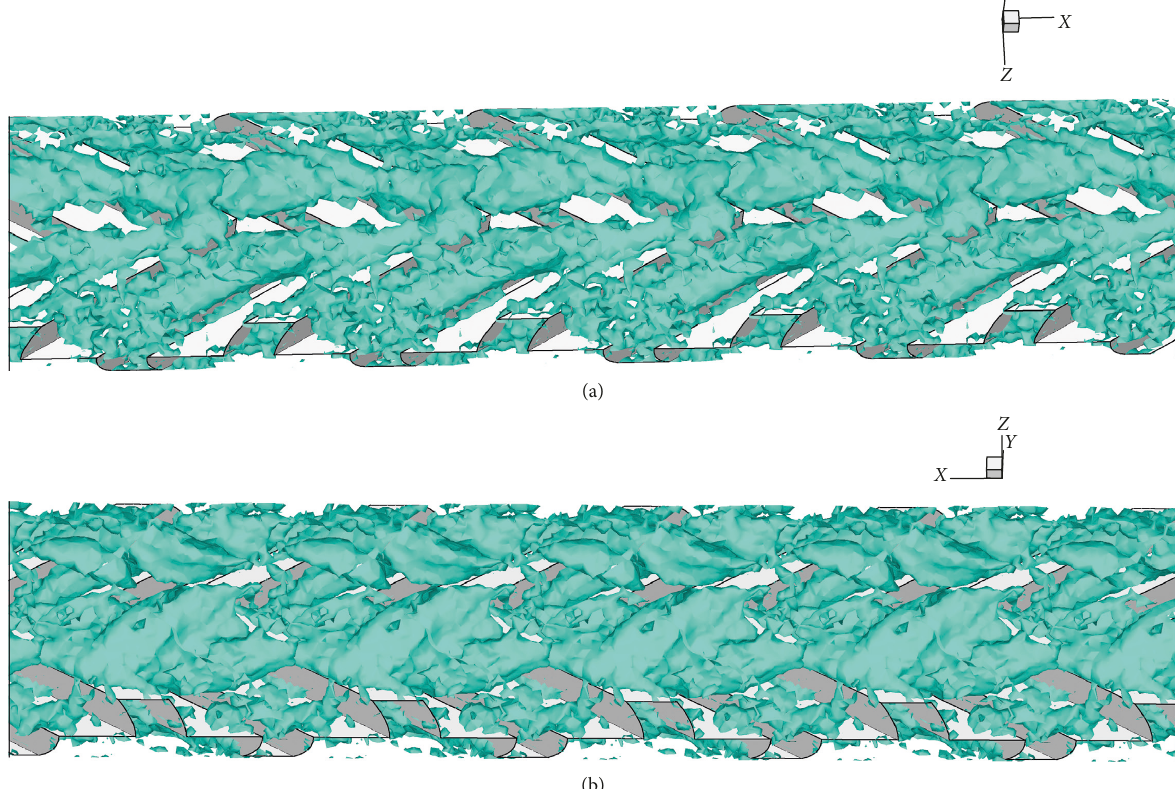
Figure 15: λ 2 isosurface of the heat exchanger tube inserted with the V-wavy surface at α (cid:28) 30 (b) V-Upstream.